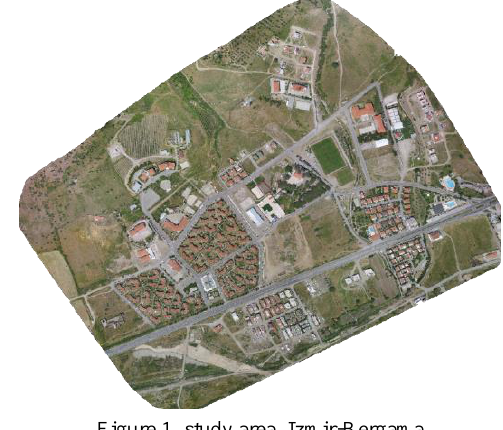
Figure 1. study area,